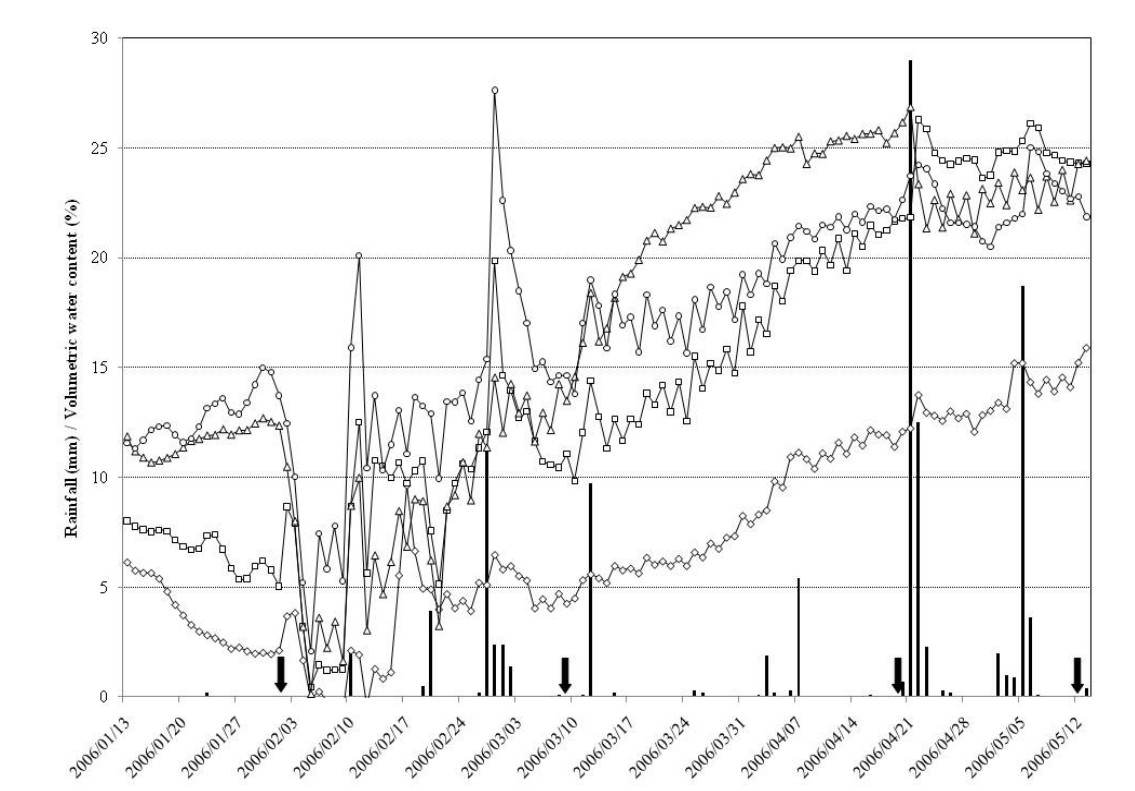
Figure 1. Daily rainfall ( ▬ ) recorded at the trial site and mean daily volumetric water content (%) in the potting mixture of potted grapevines receiving 20% (◊), 50% ( □ ), 70% (Δ) and optimal (100%) ( ○ ) irrigation as measured and recorded by ECH O soil moisture probes and Em50 data loggers from 13 January 2006 until 13 May 2006. Dates on 2 which physiological measurements were taken are indicated by black